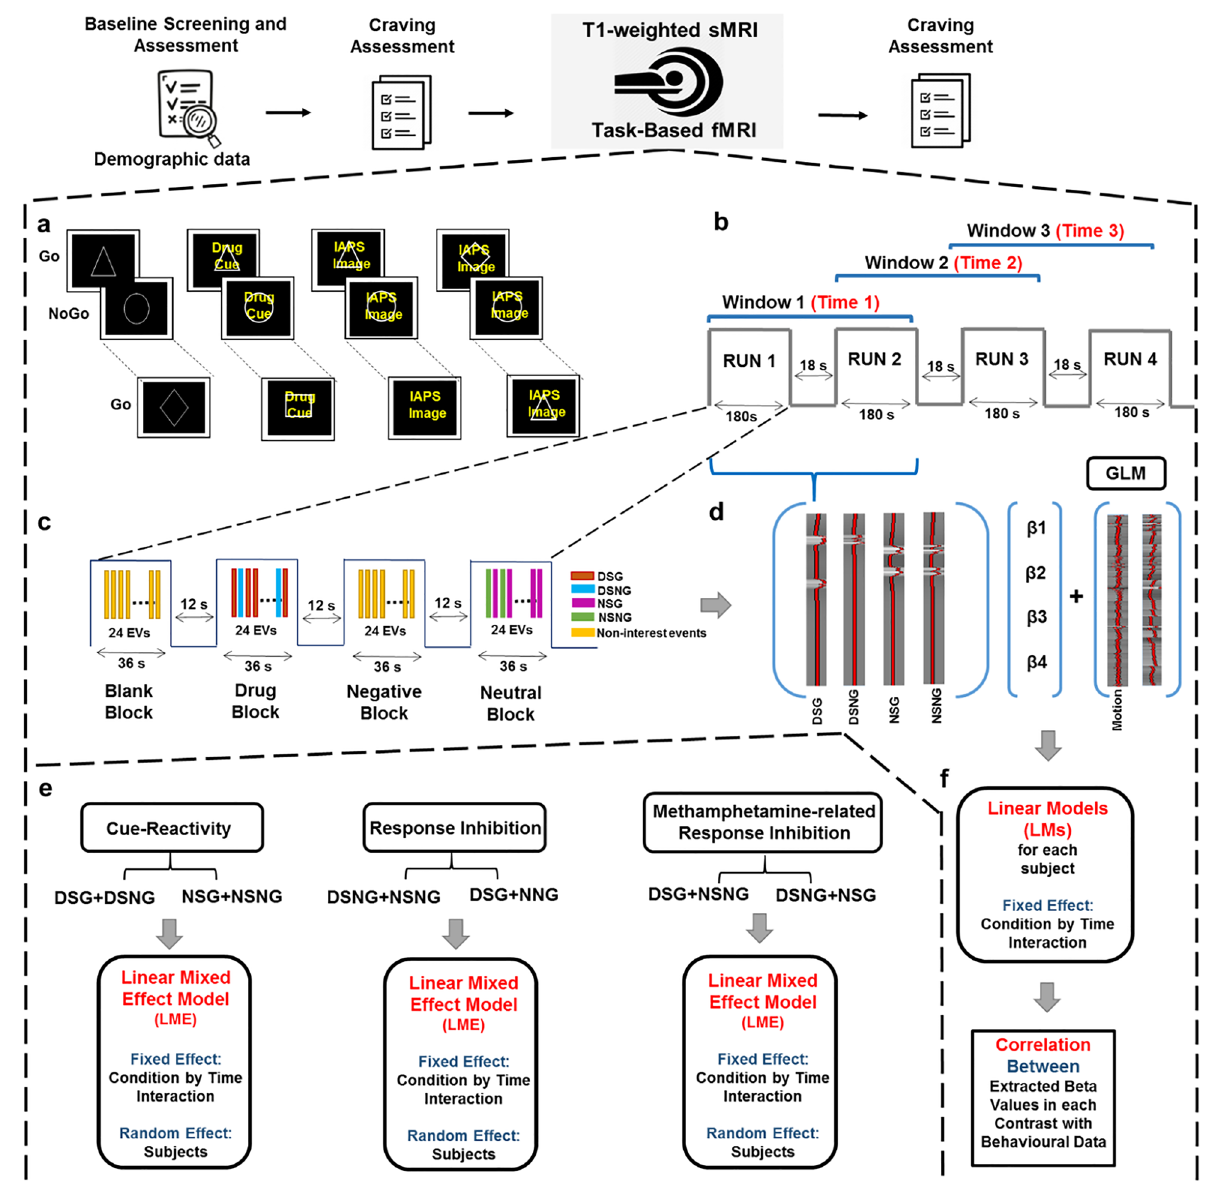
Figure 1. Task procedure. ( a ) Each run contains four blocks with Go-NoGo stimuli superimposed over different backgrounds: Blank, Drug, Neutral, and Negative emotional stimuli (180 s). The blocks are separated by resting blocks with fixation points (18 s). Go stimuli were triangles, squares, and diamonds, and the NoGo stimulus was a circle. Negative and neutral images were chosen from the IAPS database (utilized IAPS pictures are not displayed here due to the IAPS sharing limitations). Drug pictures were obtained from a publicly available and validated cue database (MOCD). ( b ) The task contains four runs and every two consecutive runs are considered a window, yielding three overlapping windows. ( c ) Successful Go and NoGo trials during Drug and Neutral blocks were modelled as four separate event types of interest: Drug Successful Go (DSG), Drug Successful NoGo (DSNG), Neutral Successful Go (NSG), and Neutral Successful NoGo (NSNG). Unsuccessful trials as well as all events on other block types were non interest events. ( d ) In each window, stimulus response functions for the four main event types (DSG, DSNG, NSG, NSNG) entered a General Linear Model (GLM) as regressors of interest. Non interest events were included to design matrix but were not carried forward to further analysis. Head motion and dvars parameters were included as nuisance regressors. ( e ) Beta coefficients for each of 6 conditions estimated in each window are entered in three Linear Mixed Effects Models (LMEs), with random intercepts for subjects and condition-by-time interaction as a fixed effect, to determine regions where coefficients have significant condition by time interactions. ( f ) Subject beta values estimated at the GLM step are entered in linear models for each subject to estimate subject-level interaction slopes at dynamically active regions for each contrast, and the associations between slopes and different clinical and behavioural variables are estimated. Imaging data were analyzed using the fMRI Expert Analysis Tool (FEAT) from FSL (FMRIB’s Software Library, https:// fsl. fmrib. ox. ac. uk/ fsl) version 6.0.3. Linear Mixed Effect Models and other statistical analyses were conducted using R software version 3.6.2 (https:// www.r- proje ct.